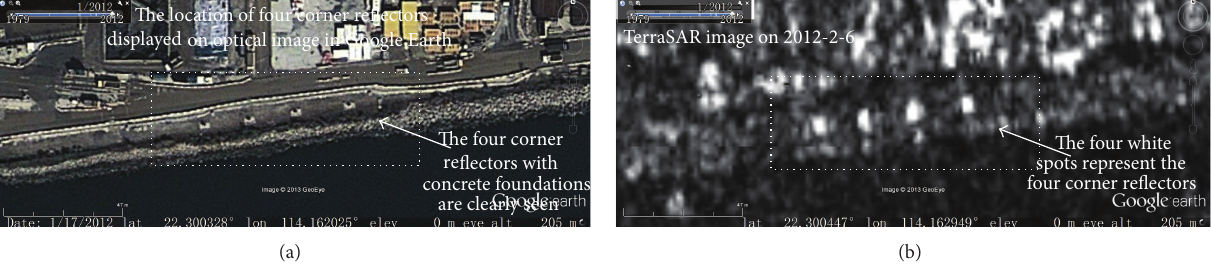
Figure 9: (a) The location of CRs in optical image displayed in Google Earth. The location is near the sea that is identical for its low intensity in RADAR images. (b) The location and intensity of the four CRs on TSX images. From the images, we can see that the background radiation in that area is very low, and the intensity of CRs is considerably